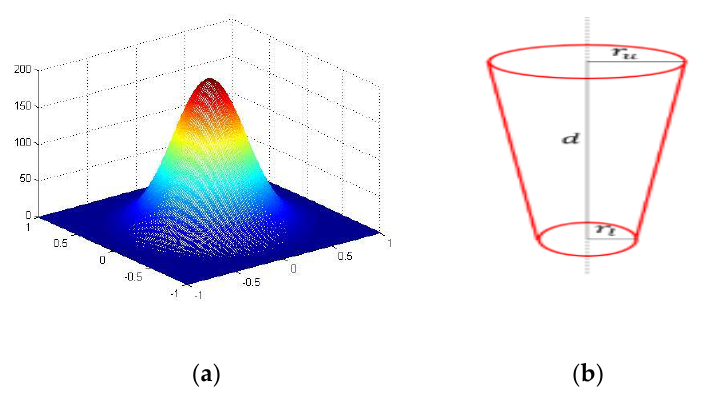
Figure 3. Laser heat source model: ( a ) Gaussian heat source; ( b ) geometric model of heat source.